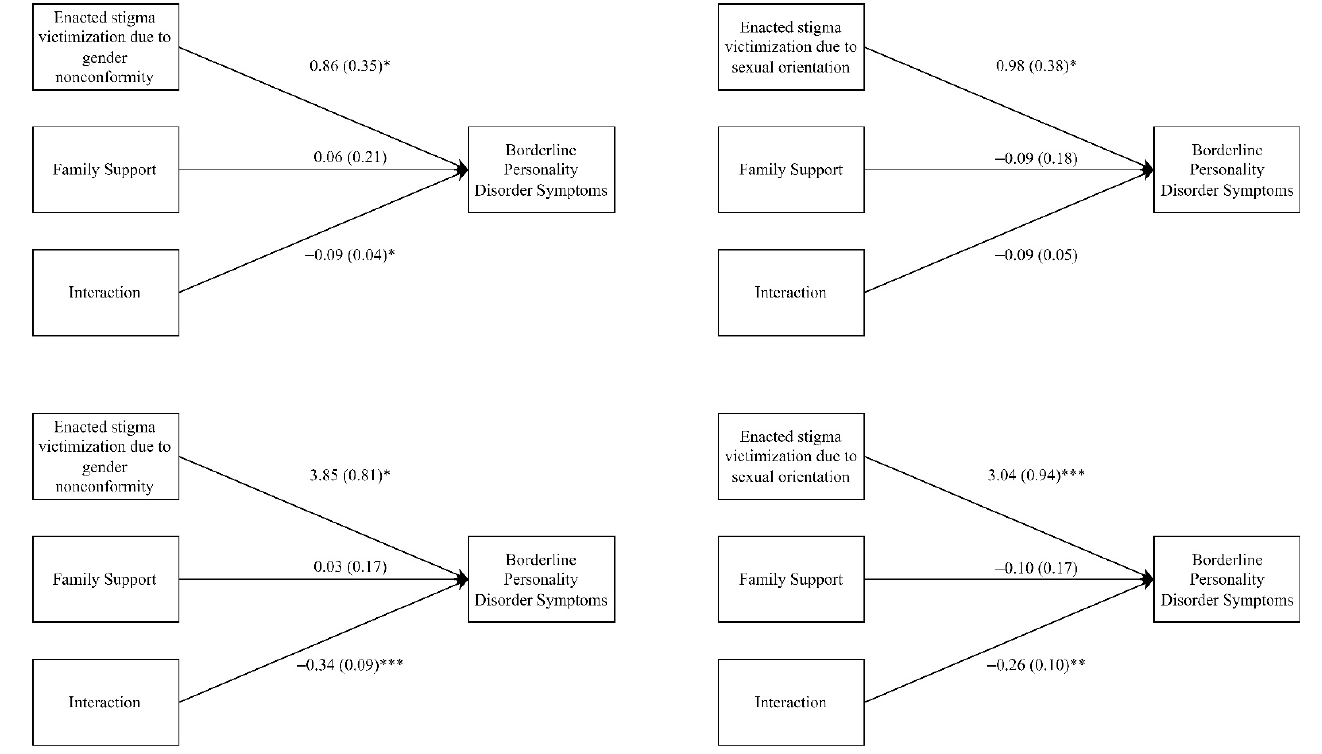
Figure 3. Visualization of the moderation models of Family Support in Association between Bullying Victimization and Borderline Personality Disorder Symptoms. Results are shown as the regression coefficient and standard error. These moderation analyses were conducted after adjustment for age, sexual orientation and depression. * p < 0.05, ** p < 0.01, *** p < 0.001.